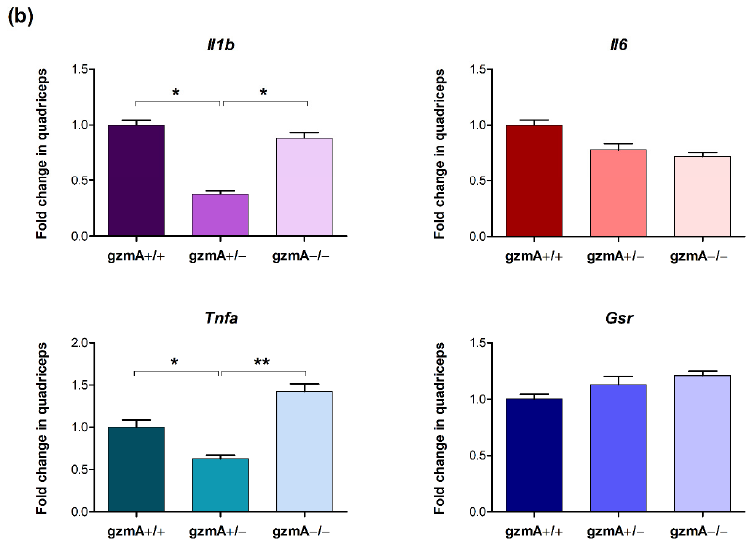
Figure 4. Il1b , Il6 , Tnfa and Gsr gene expression in spinal cord ( a ) and quadriceps ( b ) from SOD1G93A mice. Il1b , Il6, Tnfa and Gsr gene expression was analyzed in spinal cord and quadriceps of 30 SOD1+/ − mice, including gzmA+/+ ( n = 10), gzmA+/ − ( n = 10) and gzmA − / − ( n = 10) mice from the survival assay. ( a ) Il1b , Il6 and Gsr levels were found reduced in spinal cord from gzmA+/ − mice. ( b ) Il1b and Tnfa levels were reduced in quadriceps from gzmA+/ − mice. Bars represent mean ± standard error of the mean. ** p < 0.01, * p < 0.05.